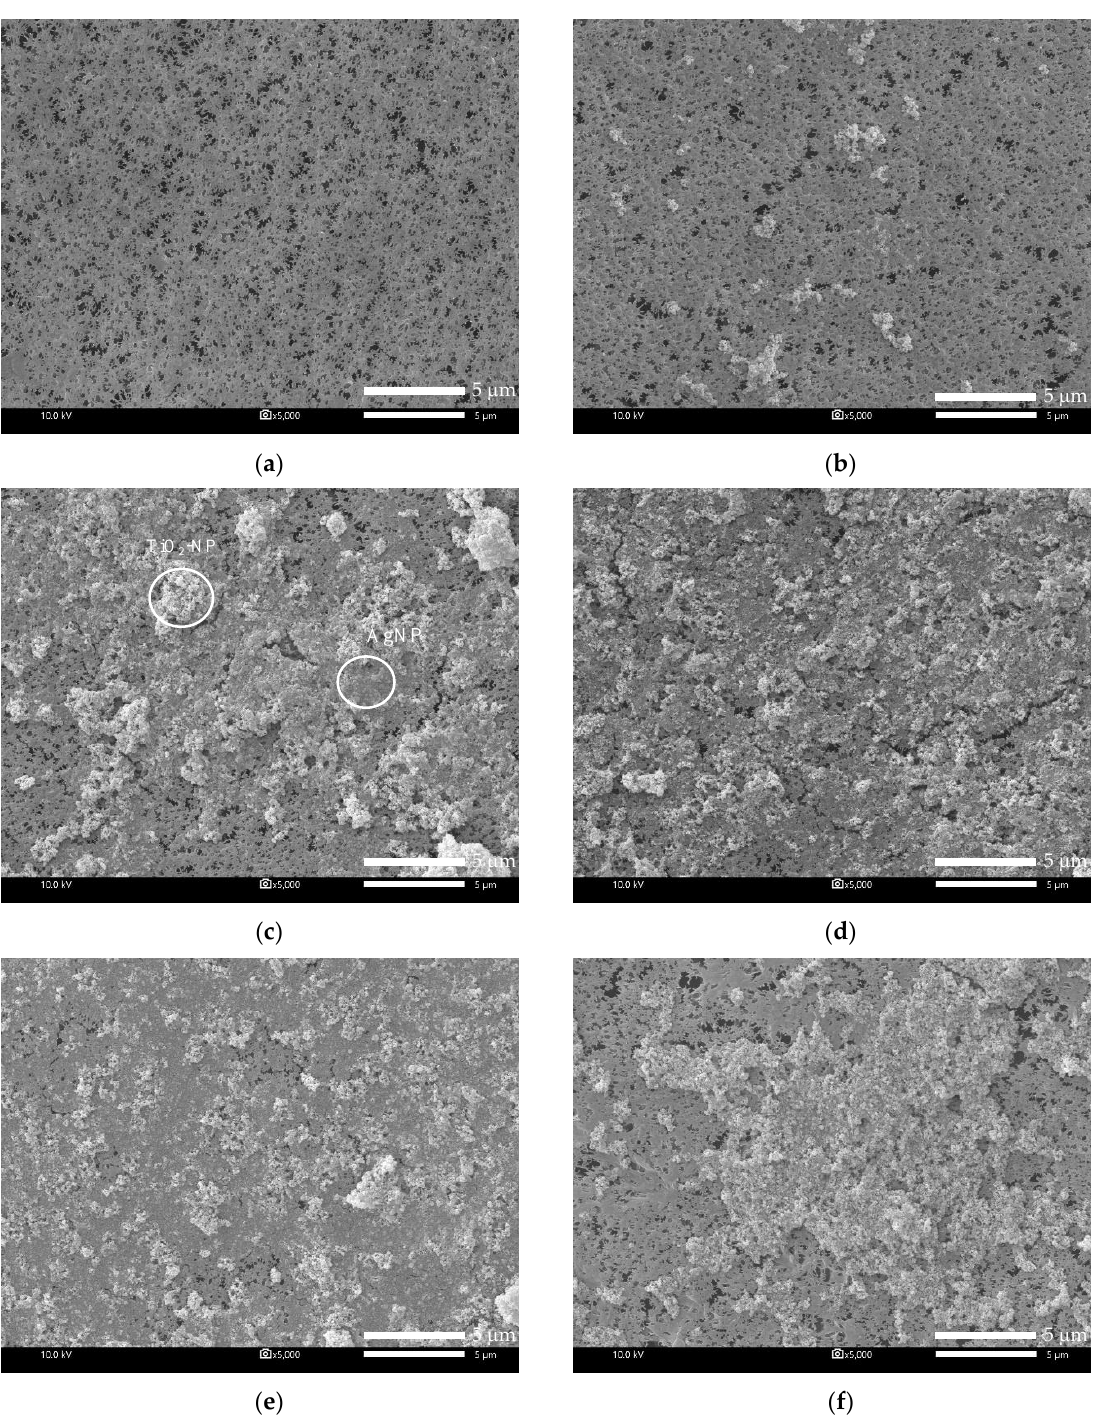
Figure 3. Scanning electron microscope (SEM) images of the membranes modified by different coating times: ( a ) M1 (original); ( b ) M2 (8 h); ( c ) M3 (16 h); ( d ) M4 (24 h) at mixed 10 ppm TiO 2 -NP / 10 ppm AgNP; ( e ) M5 (10 ppm TiO 2 -NP / 20 ppm AgNP); and ( f ) M6 (20 ppm TiO 2 -NP / 10 ppm AgNP) at coating time of 24 h (magnification ×5000).